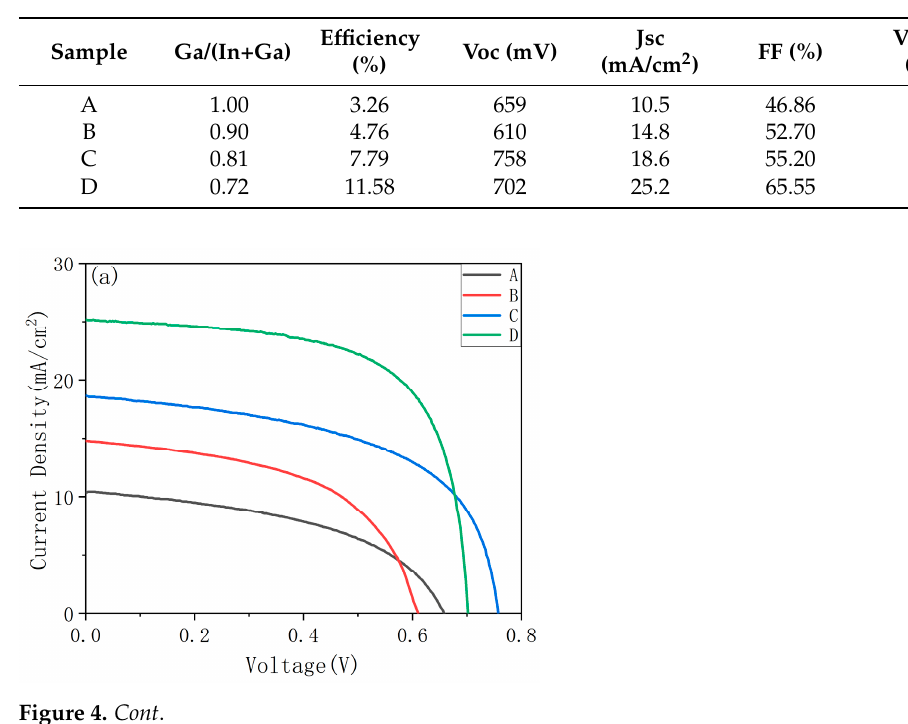
Table 3. Performance parameters of CIGS solar cells.